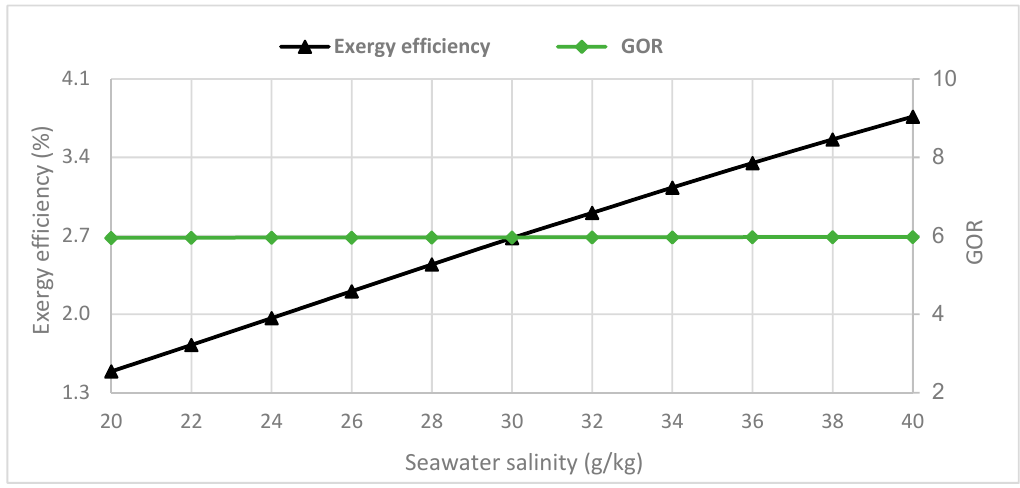
Figure 8. Exergy efficiency and gain ratio versus seawater salinity.